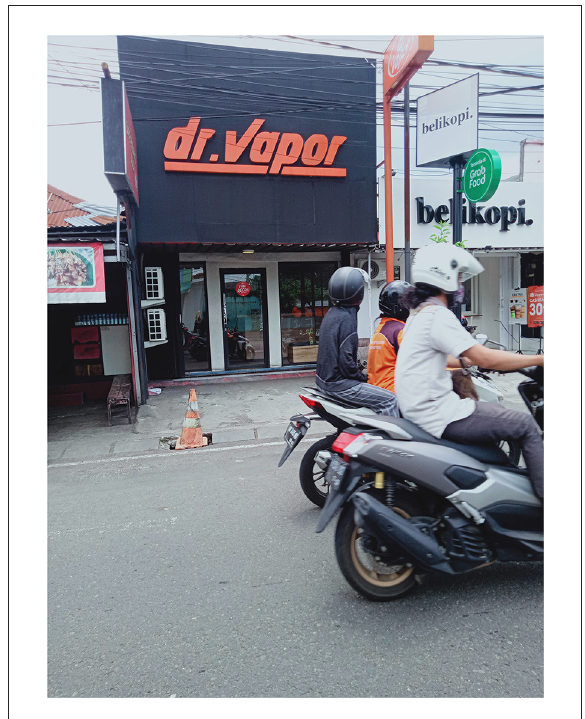
FIGURE1 An example of e-cigarette retail store in Jogjakarta (Komite Nasional Pengendalian Tembakau, 2022).